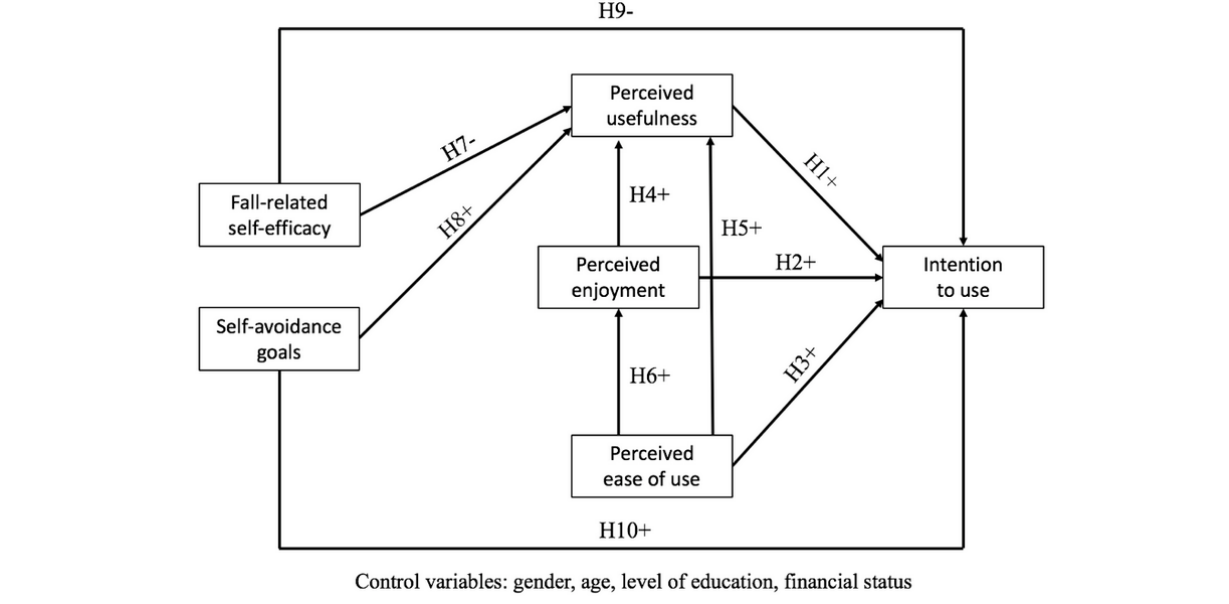
Figure 1. The hypothesized model in the